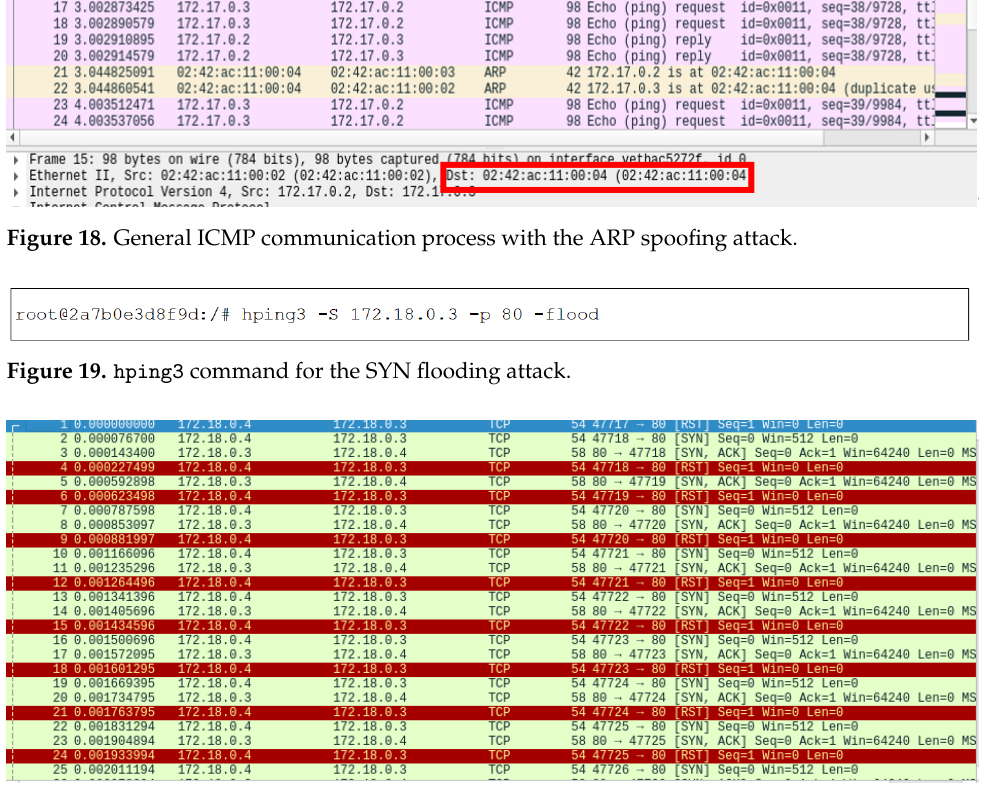
Figure 20. Wireshark execution screen with the DDoS